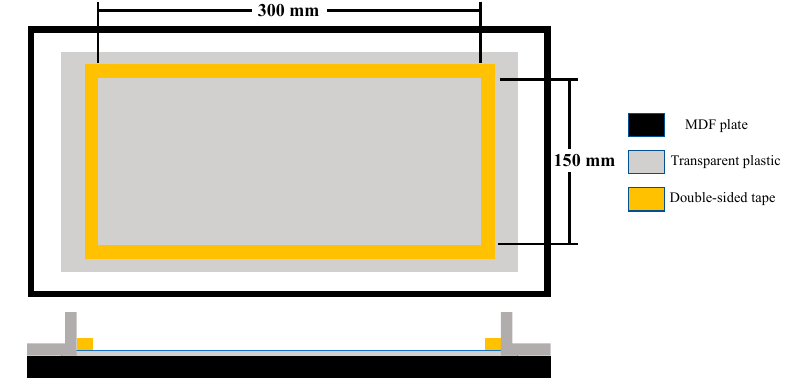
Figure 3. Schematic diagram of mold.